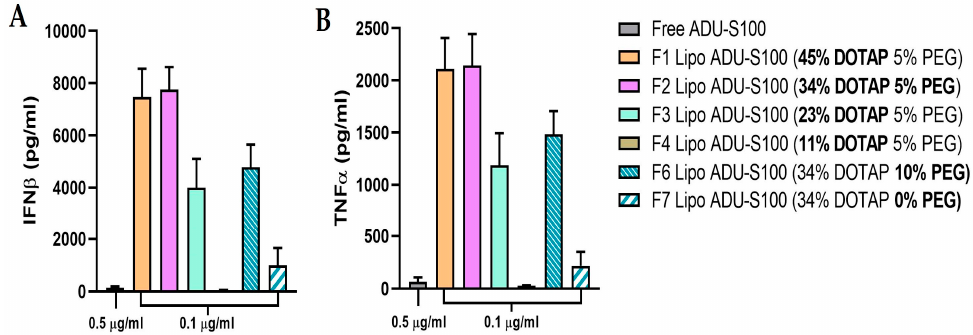
Figure 6. Liposomal ADU-S100 enhances TNF α and IFN β production. BMDCs were treated with free ADU-S100 (0.5 µ g/mL) or liposomal ADU-S100 (0.1 µ g/mL) for 24 h, and the IFN β ( A ) and TNF α ( B ) levels in the cell culture medium were determined using ELISA. Data are shown as the mean ± SD ( n ≥ 3) and are representative of three independent experiments.